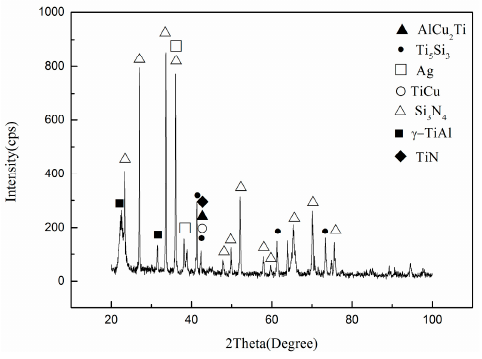
Figure 4. X-ray diffraction (XRD) results of the fracture surfaces brazed at 1173 K. Table 1. Chemical analysis (at.%) of the phases marked in Figure